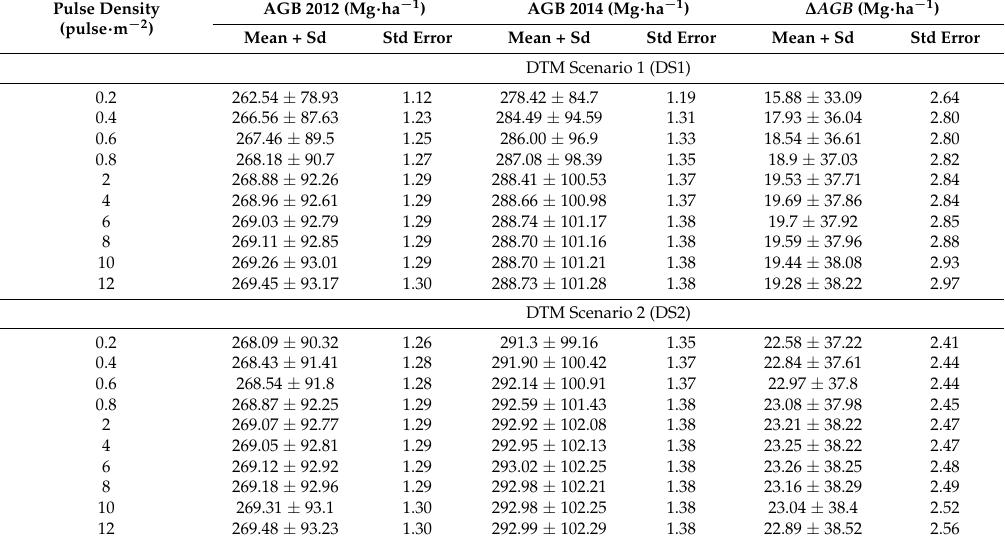
Figure 7. Map of AGB stock in 2012 ( a ), 2014 ( b ) and AGB change ( c ) at 12 pulse · m − 2 in DS2. Zoom in the AGB change maps derived at 0.2 and 12 pulse · m − 2 in DS1 ( d , e ) and DS2 ( f , g ) in an unlogged and logged unit. The maps were calculated as the mean of the 30 replicates. Table 4. Mean and standard deviation (Sd) of the parameters a and b for the AGB models in 2014. DS1: DTM Scenario 1; DS2: DTM Scenario 2. Std Error is the estimated standard error derived from the uncertainty analysis.